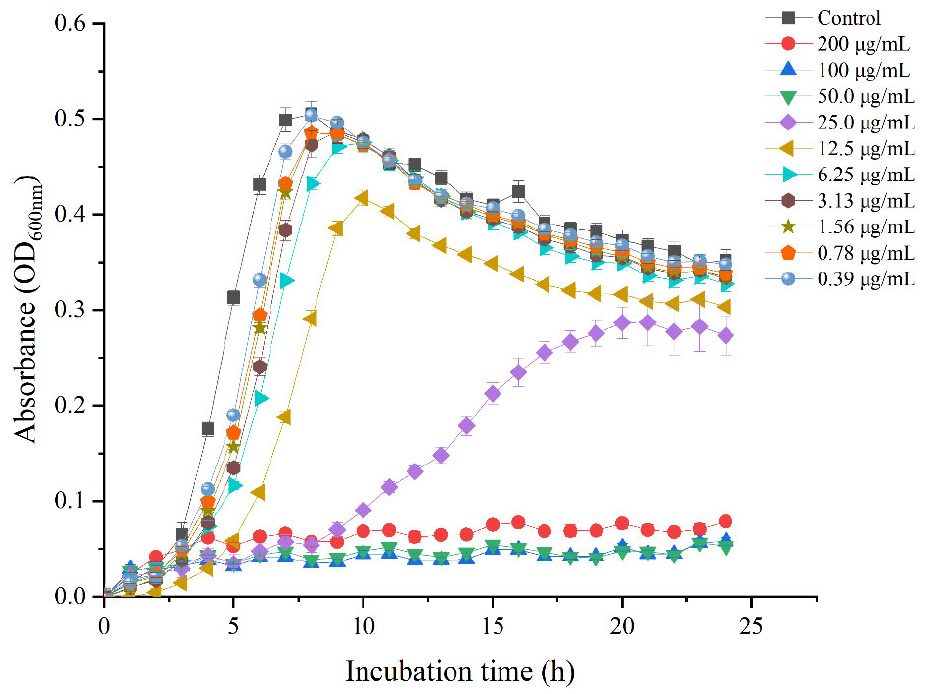
Figure 2. Growth of L. monocytogenes in TSB supplemented with various concentrations of juglone. Bars represent the standard deviation ( n = 3).